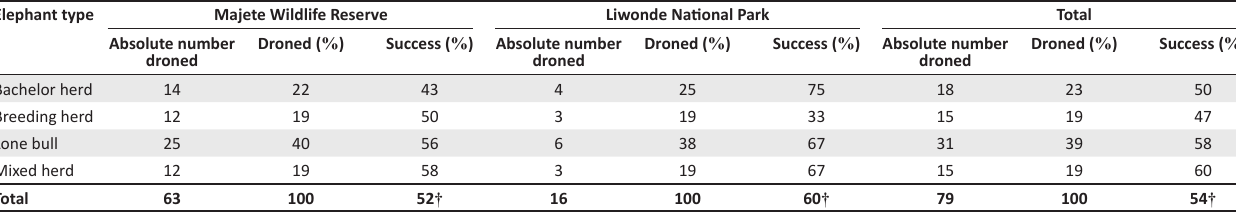
TABLE 3: The breakdown in the effort for Approach flights across Majete Wildlife Reserve and Liwonde National Park. Elephant